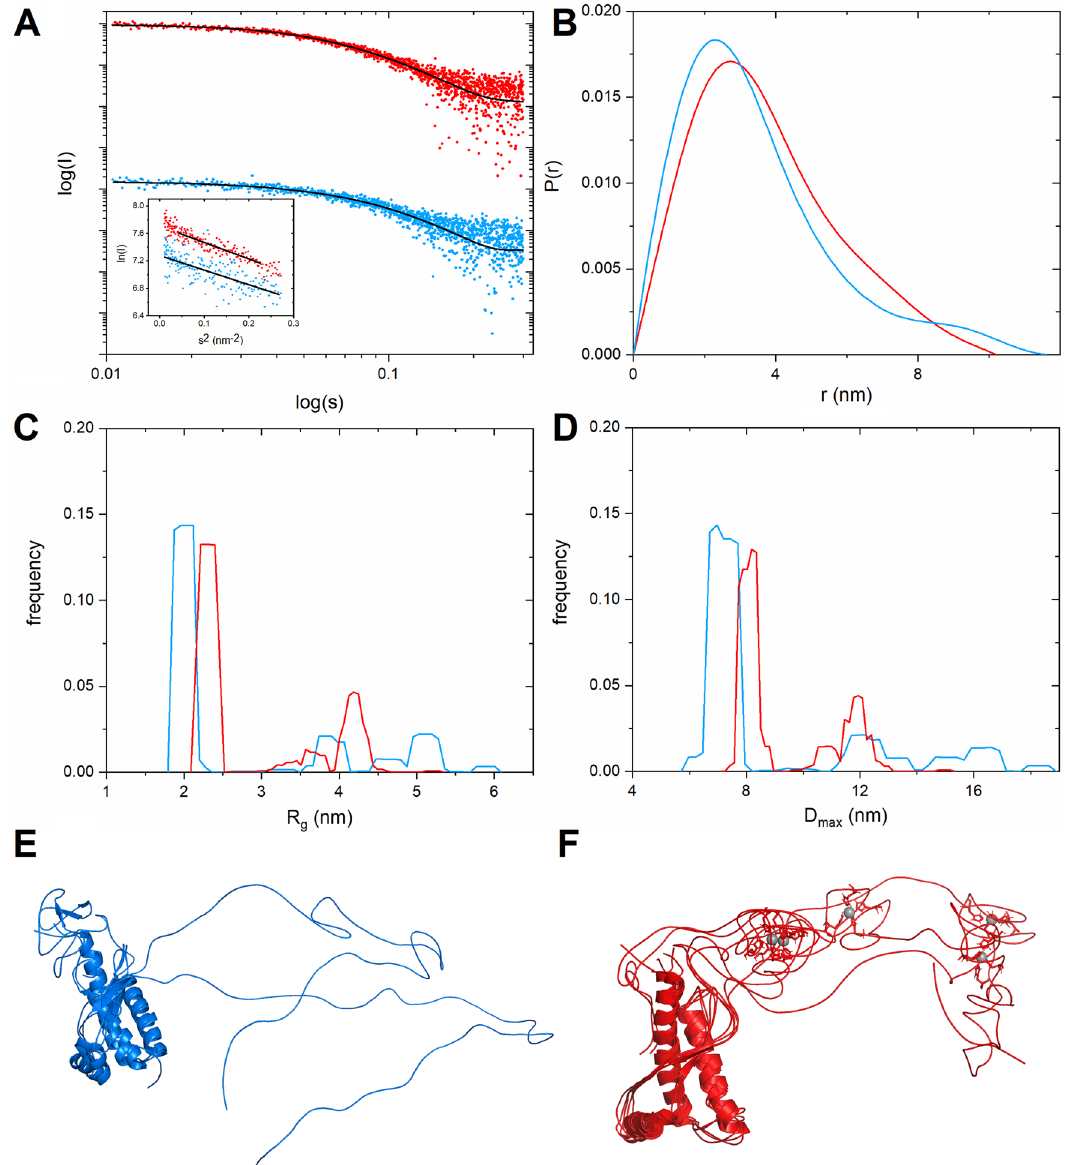
Figure 8. SAXS studies of PrP C in apo- (blue) and Zn(II)-bound (red) forms. (A) Experimental SAXS data fitted with GAJOE (black line χ 2 = 1.03 and 0.95, respectively). SAXS curves were displaced along the vertical axis for clarity. Left bottom inlet shows linear fits (black lines) in the Guinier regime. (B) P(r) functions for the two protein forms. (C) R g distribution for the two protein forms. (D) D max distribution for the two protein forms. (E,F) Pool of conformers representing apo -PrP C (E) and Zn(II)-bound PrP C (F) (5YJ4, 5YJ5), obtained from NMR and MD studies, contain in addition to the C-terminal domain also a col- lection of proposed models of the N-terminal domain 47 . However, such models do not answer what happens to PrP C upon metal ion binding. Our MD simulations indicate that the N-terminal domain, upon Zn(II) binding, interacts with the C-terminal domain and destabilizes α-helix 2. Similar tertiary folds were previously observed for murine PrP C interacting with Cu(II), Zn(II), and Cd(II) ions 36,38,48,49 , and may therefore have similar func- tions in metal ion recognition. The MD simulations suggest also that PrP C upon Zn(II) binding might follow a different folding path, with altered interactions between the β2-α2 loop and α-helix 3. In our proposed model for Zn(II)-bound PrP C , an interaction between His111 and Glu168 caused unfolding of the α-helix 3 C-terminal part. Such an interaction between His111 and the β2-α2 loop might be a first step in PrP C unfolding and fibrillization. Introduction of different amino acids, in the form of glutamines in the β2-α2 loop, has previously been shown to shorten the lag phase for mouse PrP C fibrillization 50 . As histidine residues at pH 7.4 can act both as donors and acceptors for hydrogen bonding, it is possible that His111 can form hydrogen bonds with glutamines from the β2-α2 loop, disturbing the α-helix 3 and resulting in faster PrP C fibrillization. On the other hand, Zn(II) binding to PrP C could